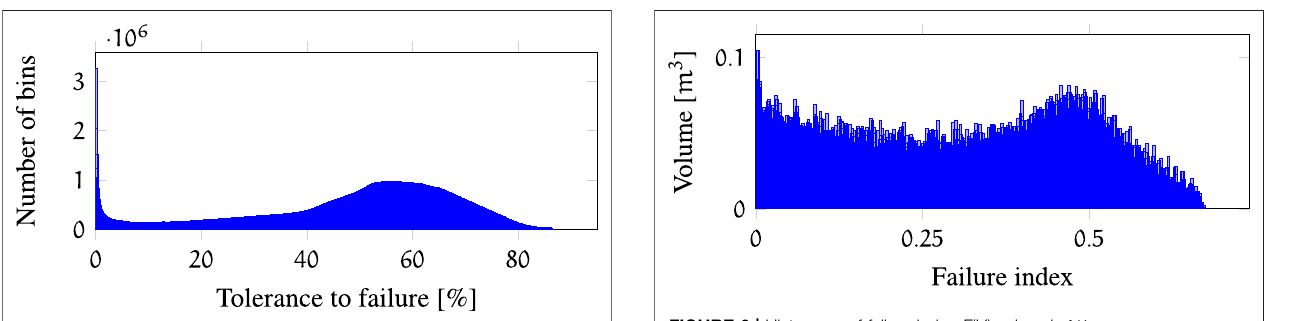
FIGURE 6 | Histogram of failure index F ( V i ) values in W f .